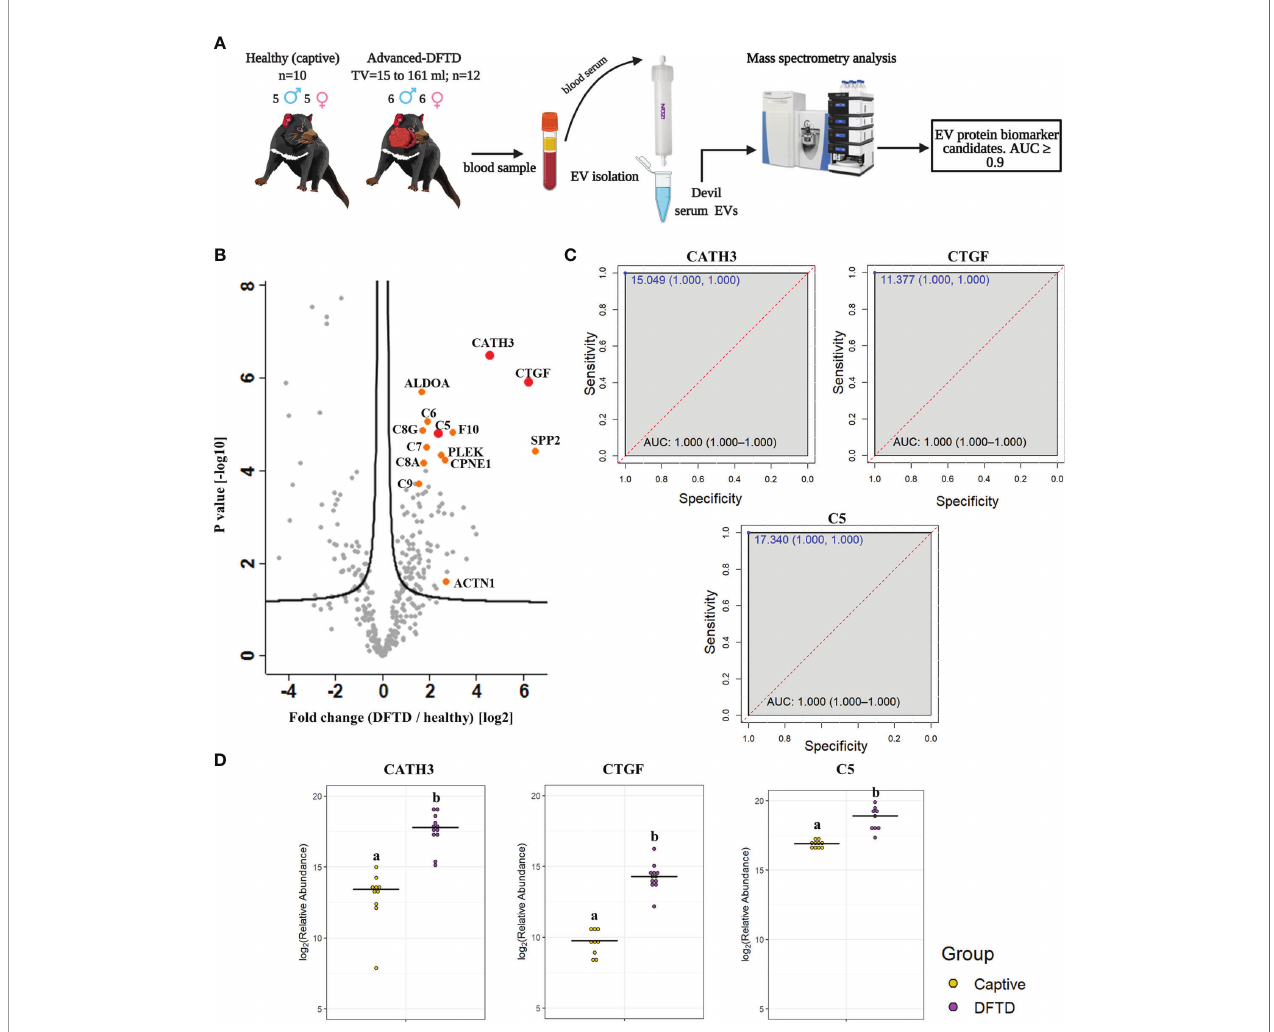
FIGURE 2 | Discovery cohort. (A) Extracellular vesicles (EVs) were isolated from 22 devil serum samples (12 DFTD-advanced and 10 healthy captive devils) by size exclusion chromatography columns. EVs were analyzed by mass spectrometry to explore DFTD EV biomarker candidates. TV = tumor volume. (B) Volcano plot of protein relative abundance fold changes (log 2 ) between EVs derived from advanced stage DFTD and healthy devils vs fold change signi fi cance. Proteins denoted in red are perfect disease status classi fi ers (area under the receiver operating characteristic curve [AUC] = 1.0). Orange denotes proteins with an AUC > 0.95. (C) Receiver operating characteristic curve analysis for the EV sample proteins CATH3, CTGF, and C5 (DFTD relative to healthy controls). The dashed red identity line indicates random performance. The cut-off values were determined using Youden ’ s index and are indicated in blue at the left top corner of the ROC curve, and speci fi city and sensitivity are indicated in brackets, respectively. (D) Dot plots depicting the relative abundance of the proteins CATH3, CTGF and C5 obtained from healthy animals and devils with advanced stages of DFTD, different letters “ a ” and “ b ” indicate signi fi cant differences between groups (Student ’ s t-test, FDR-corrected p <